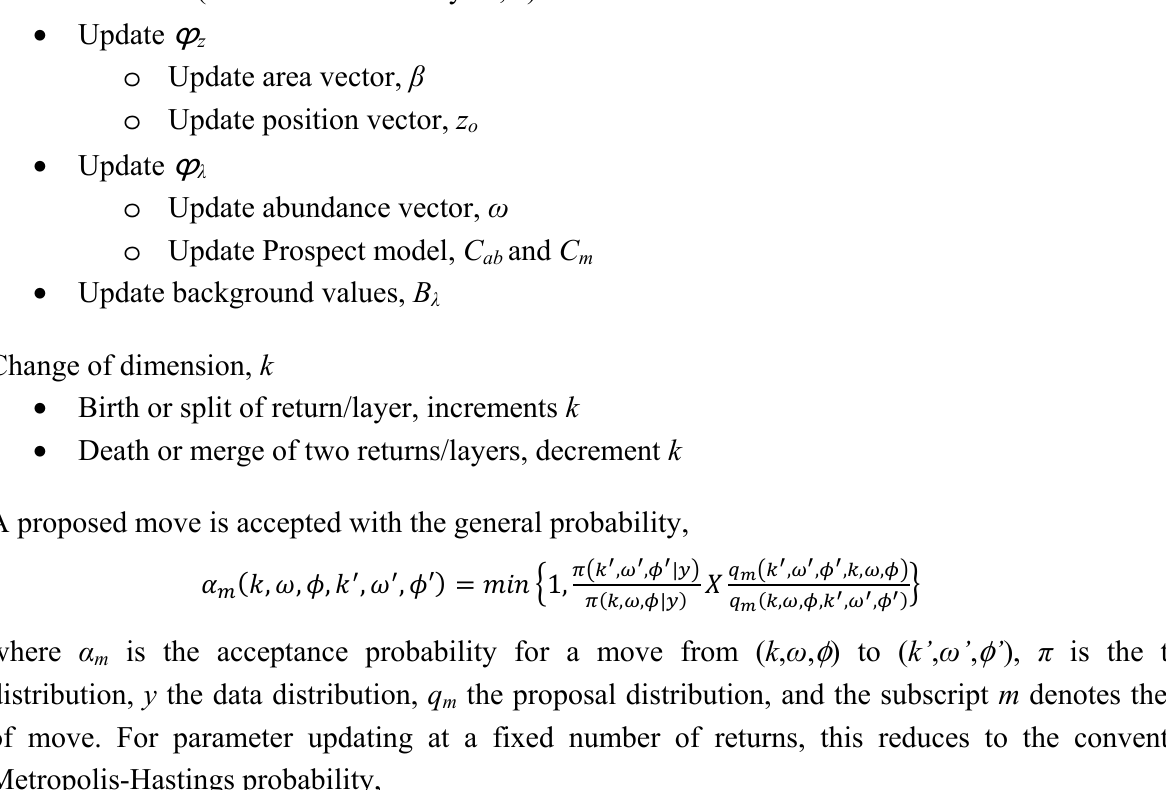
Algorithm 1 : Updating of parameters in a multispectral RJMCMC